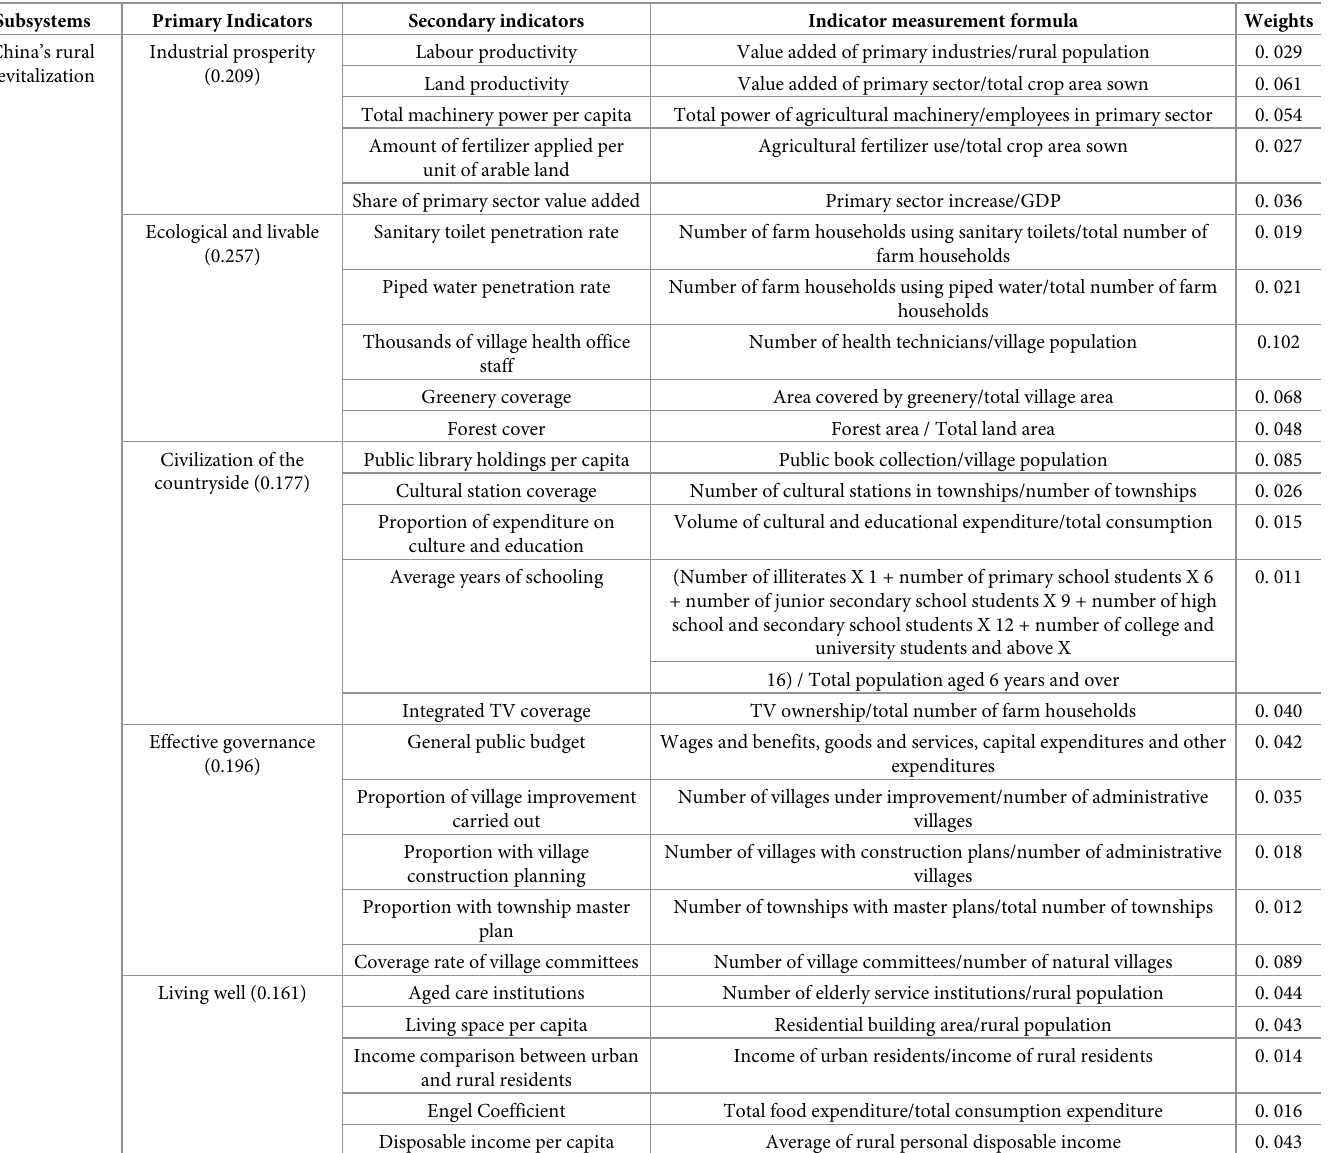
Table 1. Index system of China’s rural revitalization and digital economy